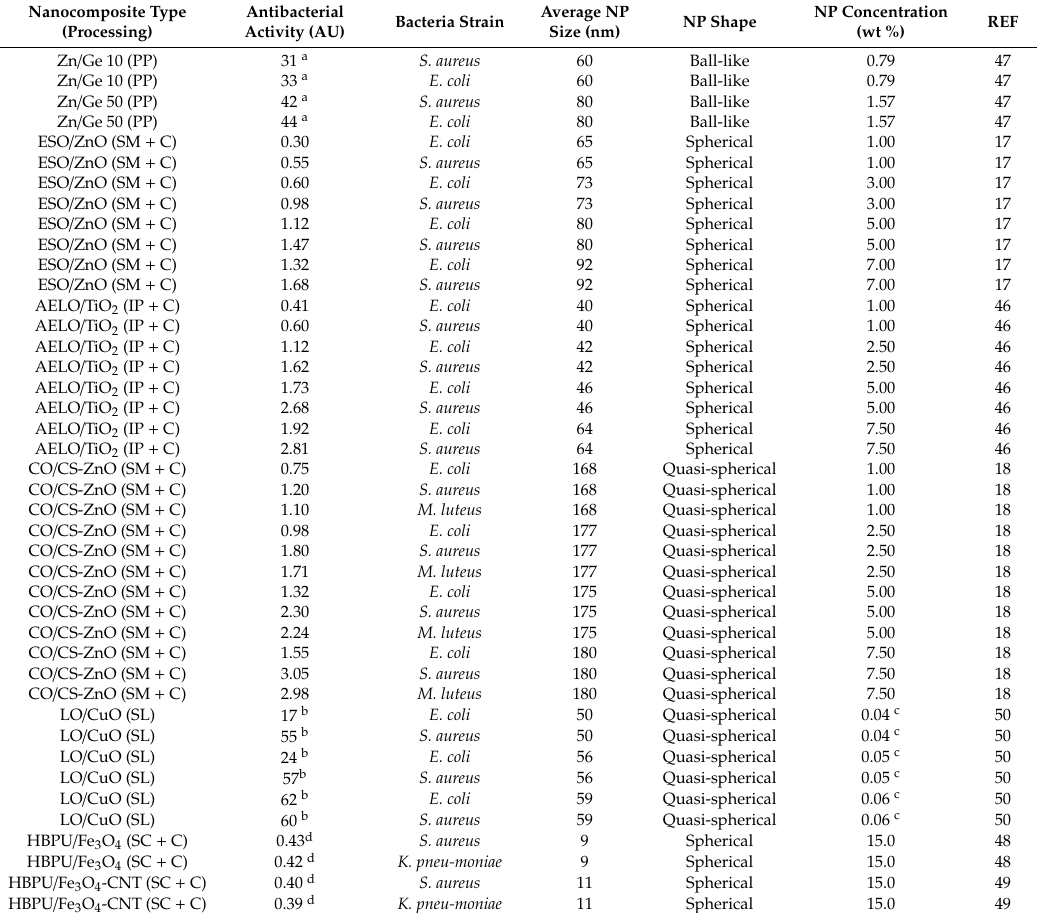
Table 3. Antibacterial activity of VO / MO-NPs